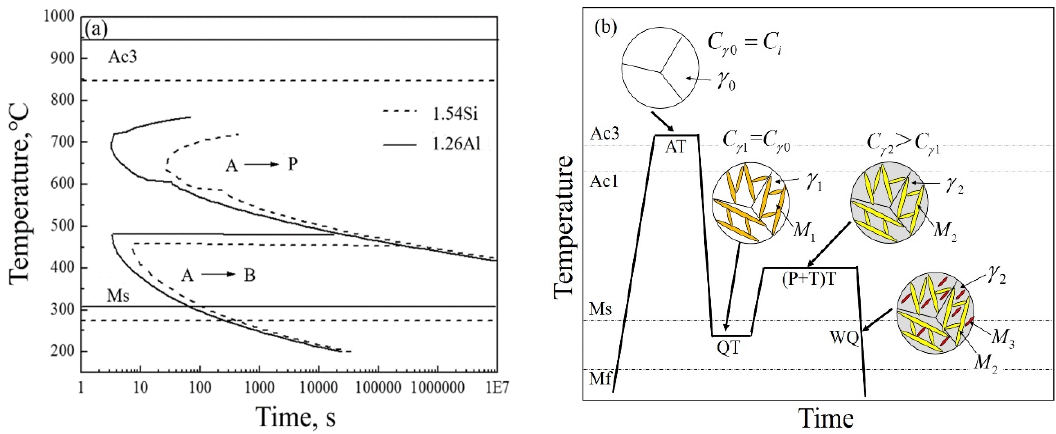
Figure 8. ( a ) the transformation curves of TTT (Time–Temperature–Transformation); ( b ) the